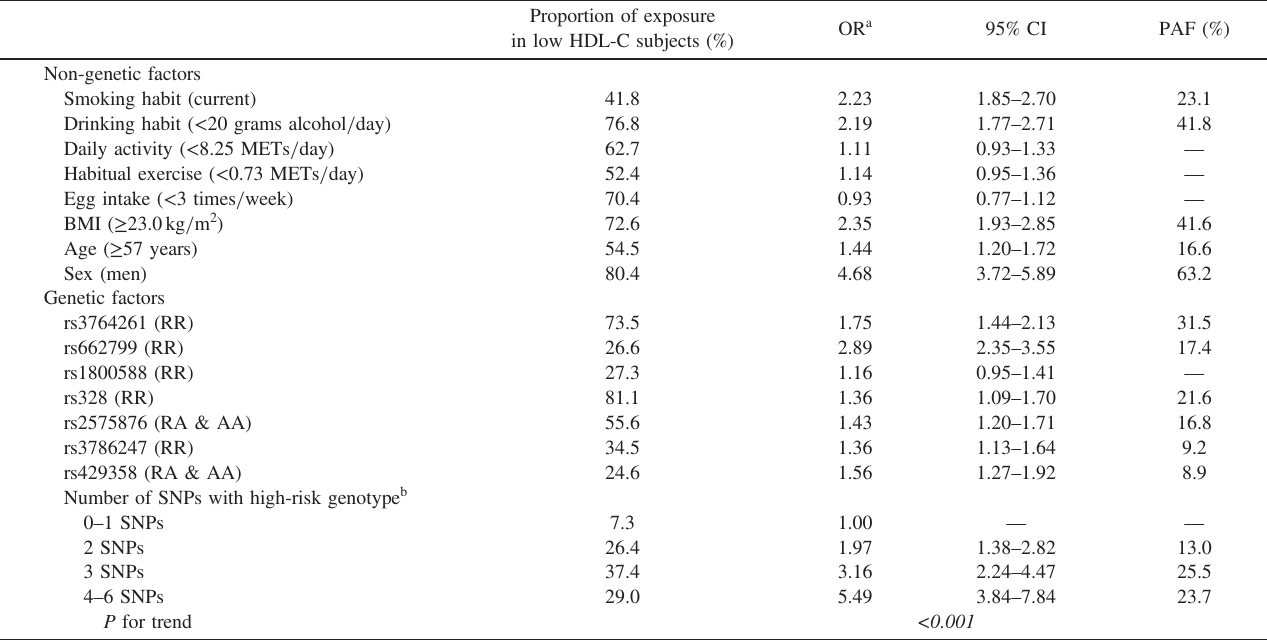
Table 5. Population attributable fractions of non-genetic and genetic factors for low